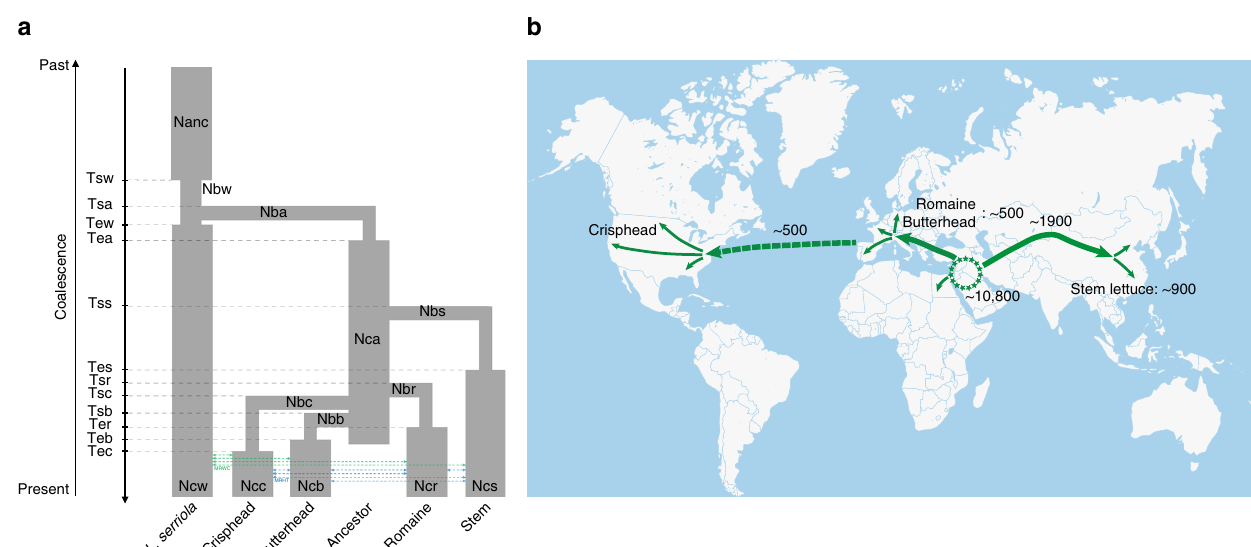
Fig. 2 Schematic representations of the demographic history scenarios of lettuce a Schematic representation of demographic scenario using Fastsimcoal2 . Gene fl ow among different populations was allowed. Two symmetrical migration parameters were used, one between different horticultural types (MRHT), and the other between L. serriola and each horticultural type (MRWC). Only the best model is shown, which assumes that there was a single domestication event and that all horticultural types originated from the same ancestral cultivated population. See Supplementary Table 9 for the meaning of the parameters and their estimated values. b The map showing the origin and dispersal of domesticated lettuce. The star circle indicates the center of lettuce domestication, with possible dispersal routes shown by arrows 4 . The numbers indicate the likely time (in years before present) of domestication, dispersal and origin of new horticultural